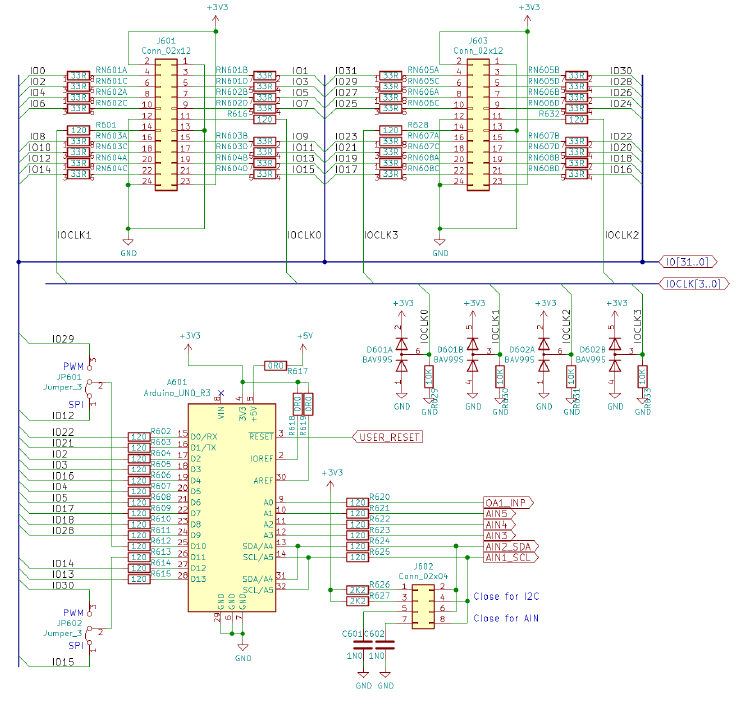
Figure 6. Digital I/O